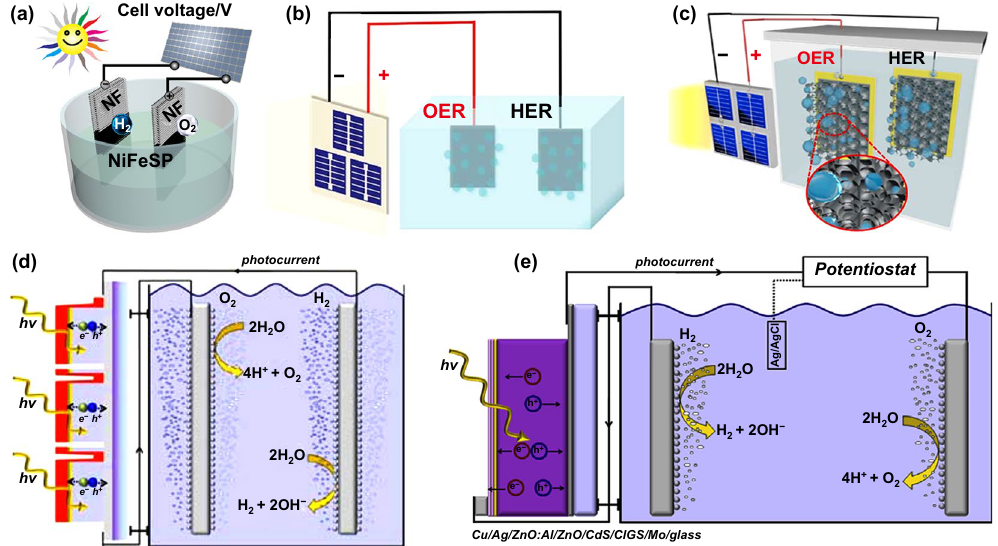
Fig. 9 a Schematic diagram of the solar-driven system with a Si solar cell for overall water splitting. Reproduced with permission from Ref. [127]. Copyright 2017 American Chemical Society, b unassisted water splitting using NCS/NCP/NF as the electrodes and Si solar cells as the light absorber. Reproduced with permission from Ref. [122]. Copyright 2018 Royal Society of Chemistry, c unassisted water splitting by using a combination of an NiFe electrolyzer and Si solar cells. Reproduced with permission from Ref. [128]. Copyright 2017 Elsevier Inc., d schematic diagram of the CIGS absorber connected with the catalyst module by wires. Reproduced with permission from Ref. [132]. Copyright 2013 Royal Society of Chemistry, e schematic diagram of the CIGS electrode connected with a working electrode with deposited catalyst in the electrolyte by wires. Reproduced with permission from Ref. [133]. Copyright 2013 Elsevier